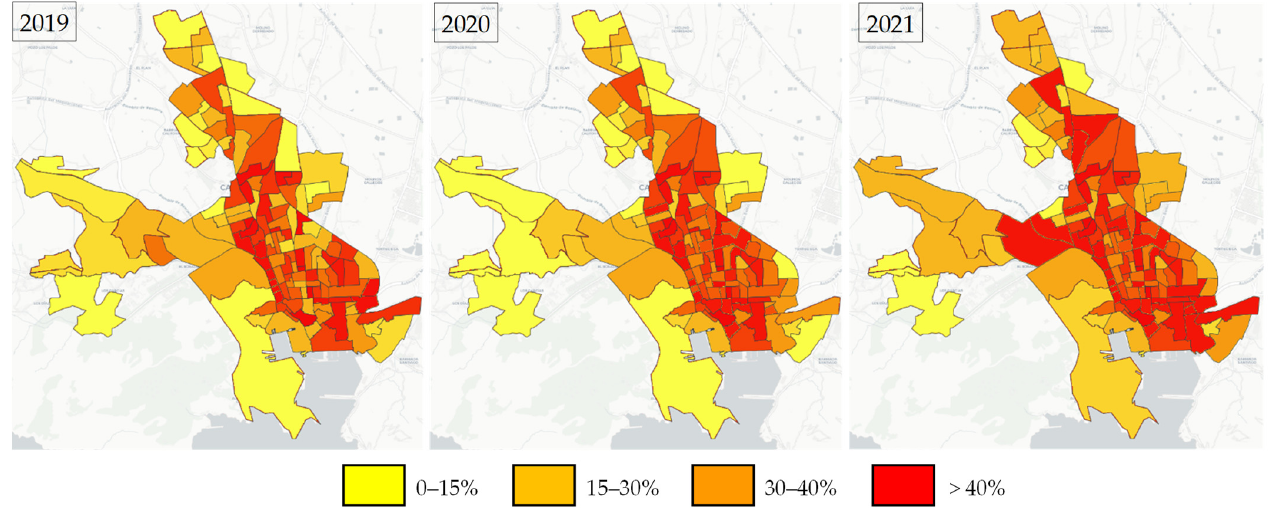
Figure 9. Evolution of the relative weight of the PVUD indicator in the city’s sectors in the months of March and April of 2019, 2020, and 2021.